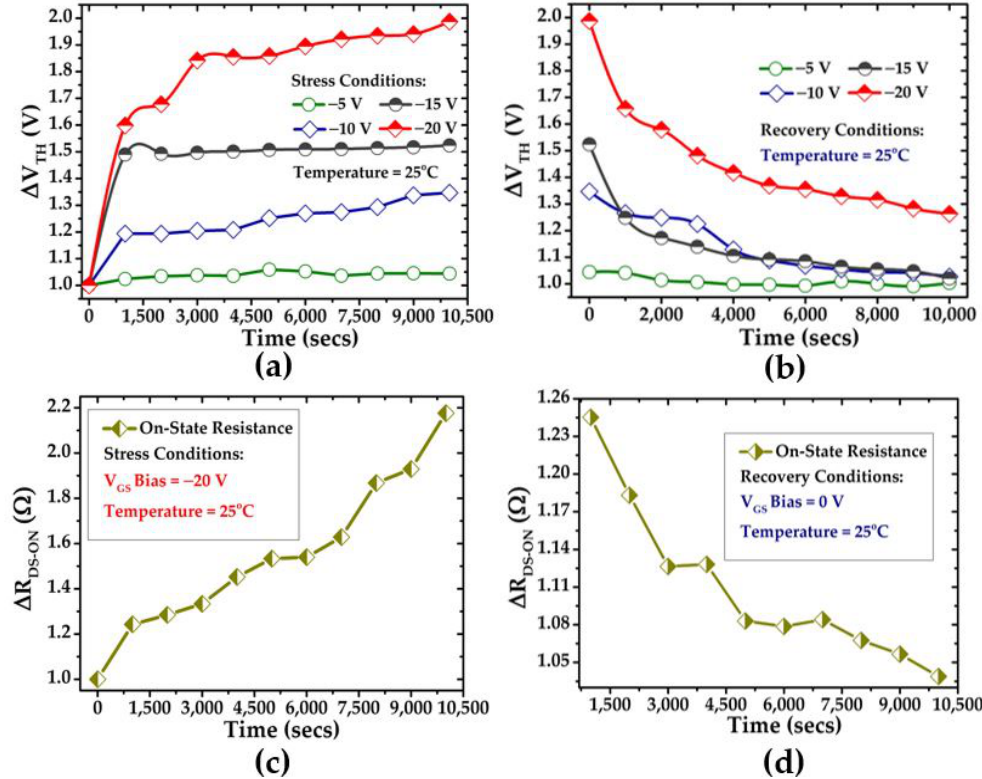
Figure 6. Extracted ( a ) (cid:52) V TH shift under stress conditions , ( b ) (cid:52) V TH recovery under room temper- ature, ( c ) extracted (cid:52) R DS-ON degradation under stress conditions, and ( d ) (cid:52) R DS-ON recovery under room